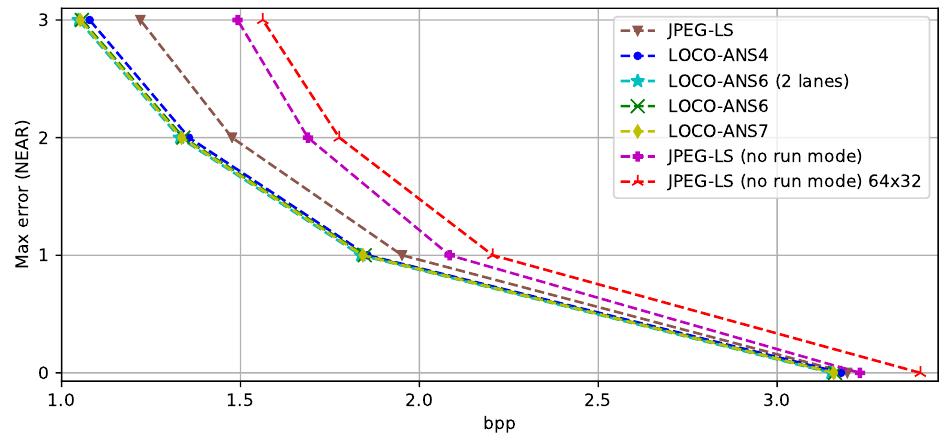
Figure 10. Mean bits per pixel (bpp) obtained by JPEG-LS, JPEG-LS without run mode and